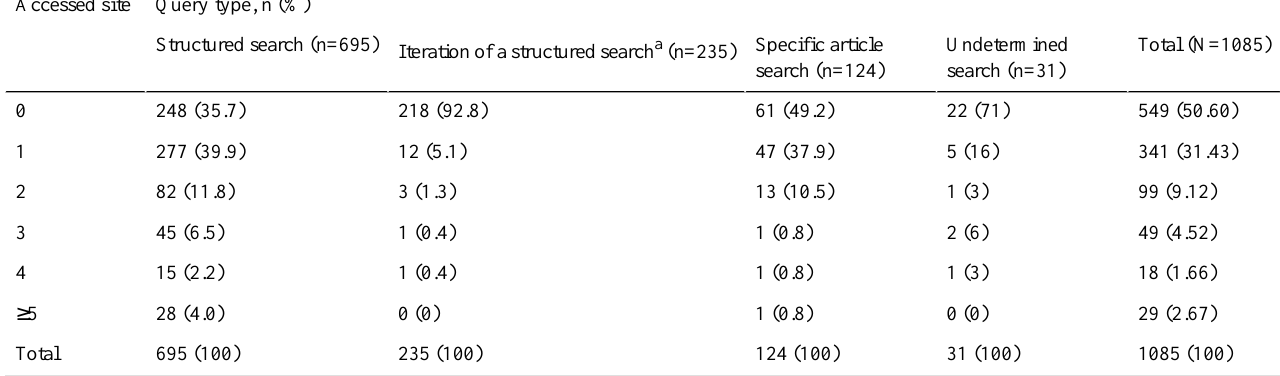
Table 4. Number of accessed sites across 1085